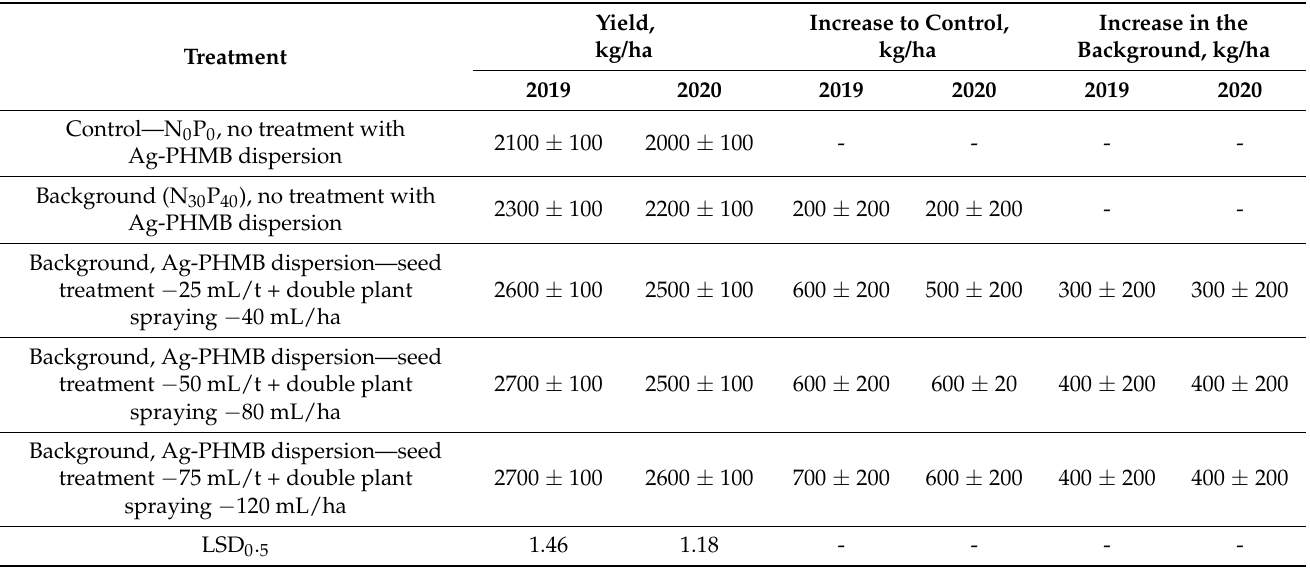
Table 4. Effect of the treatment of soybean plants with Ag-PHMB dispersion on soybean yield